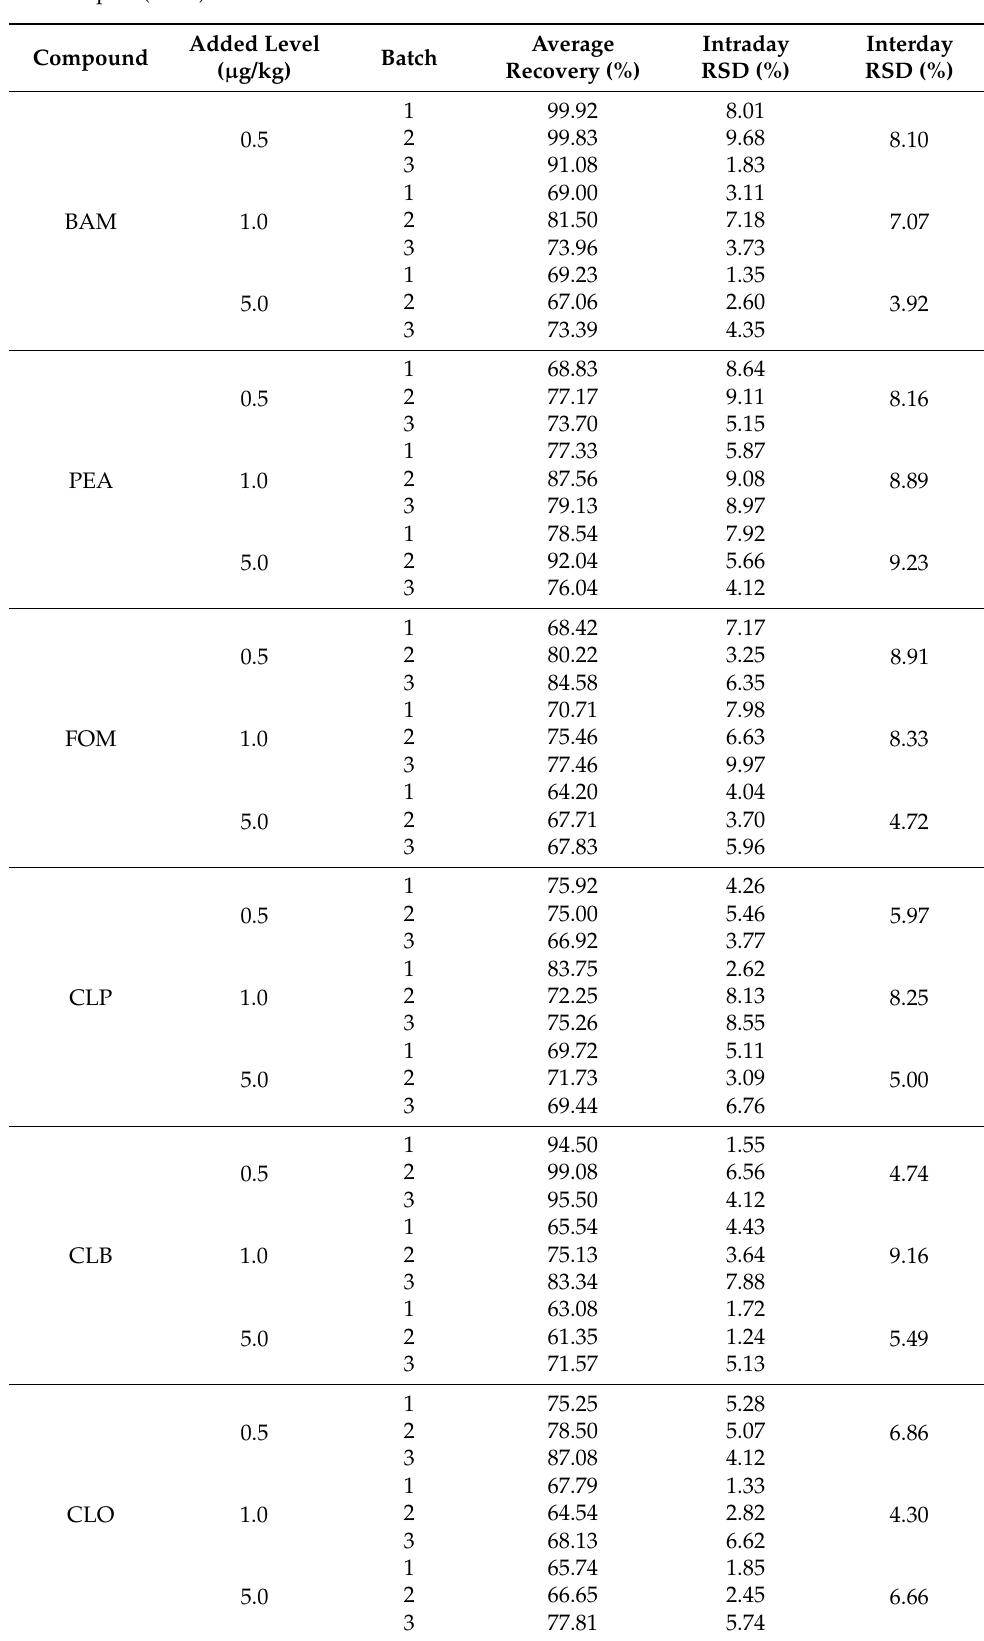
Table A2. Average recovery, intraday precision, and interday precision of the sixteen β -agonists in beef samples (n =